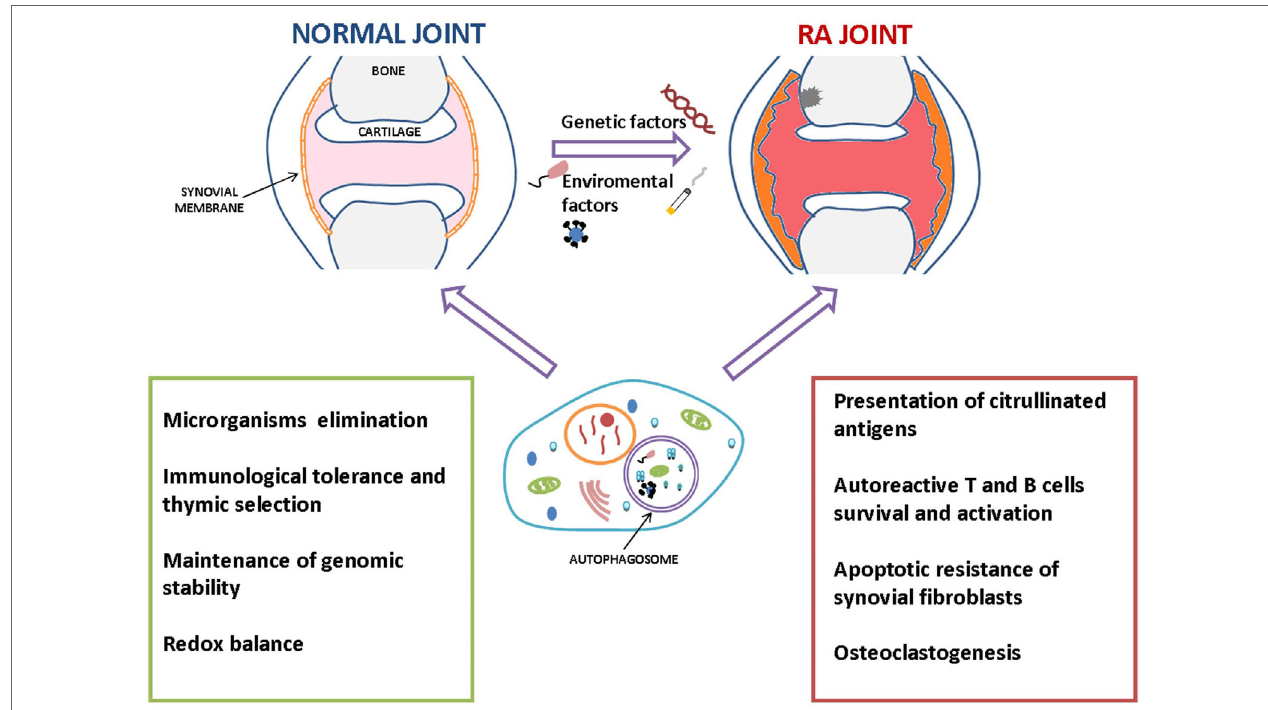
FiGURe 2 | Summary of the possible roles of autophagy in the pathogenesis and progression of rheumatoid arthritis (RA). Autophagy could prevent the development of autoimmunity scenario by eliminating intracellular pathogens and maintaining immune cells homeostasis, including regulation of immunological tolerance mechanisms. However, once it occurs, autophagy could take part in RA progression in several ways, e.g., participating in perpetuation of autoimmune response promoting the survival of inflammatory and autoreactive cells, cytokines production, and presentation of citrullinated